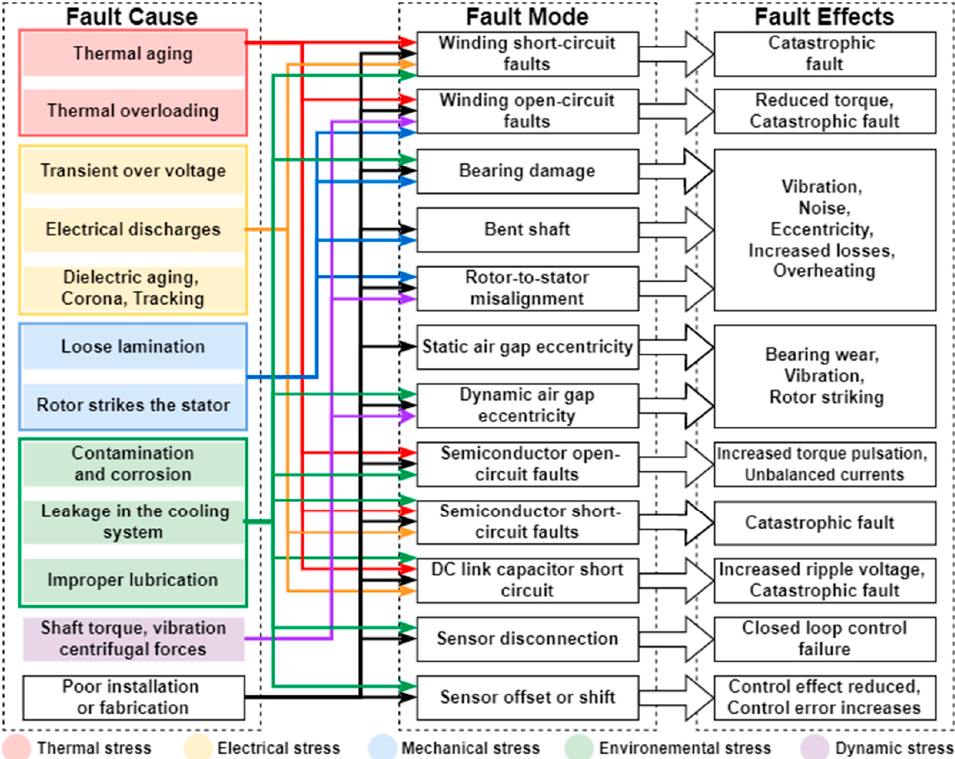
Figure 3. Causes and effects of various fault modes in EV powertrains.